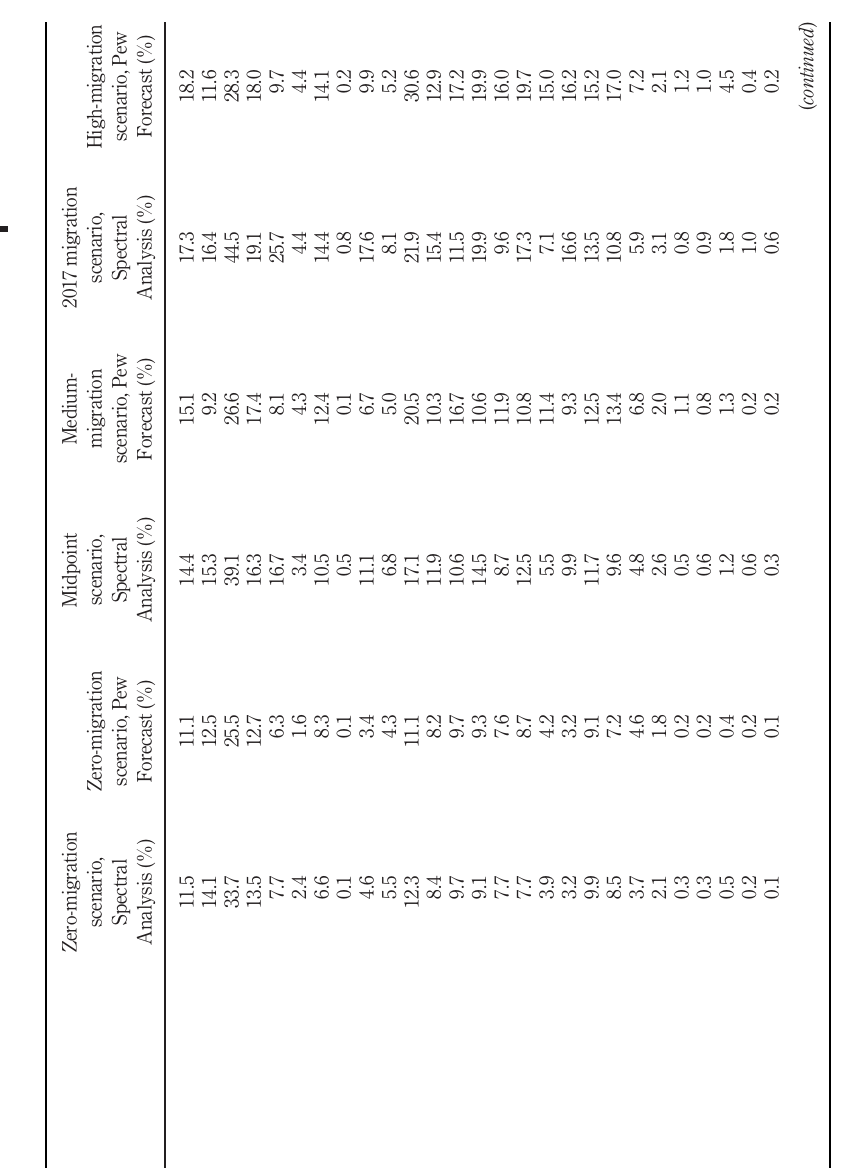
Table IV. Benchmarking spectral analysis proportion estimates to the Pew Research Centre (2017)